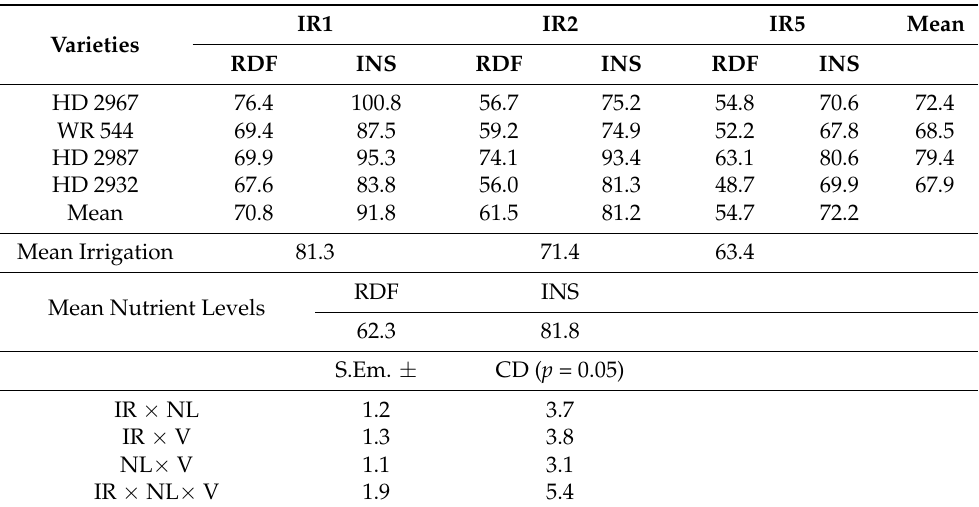
Table 7. Interaction effect of nutrient management levels, irrigation schedules, and varieties on alkaline phosphates ( µ g PNP/g soil/h).